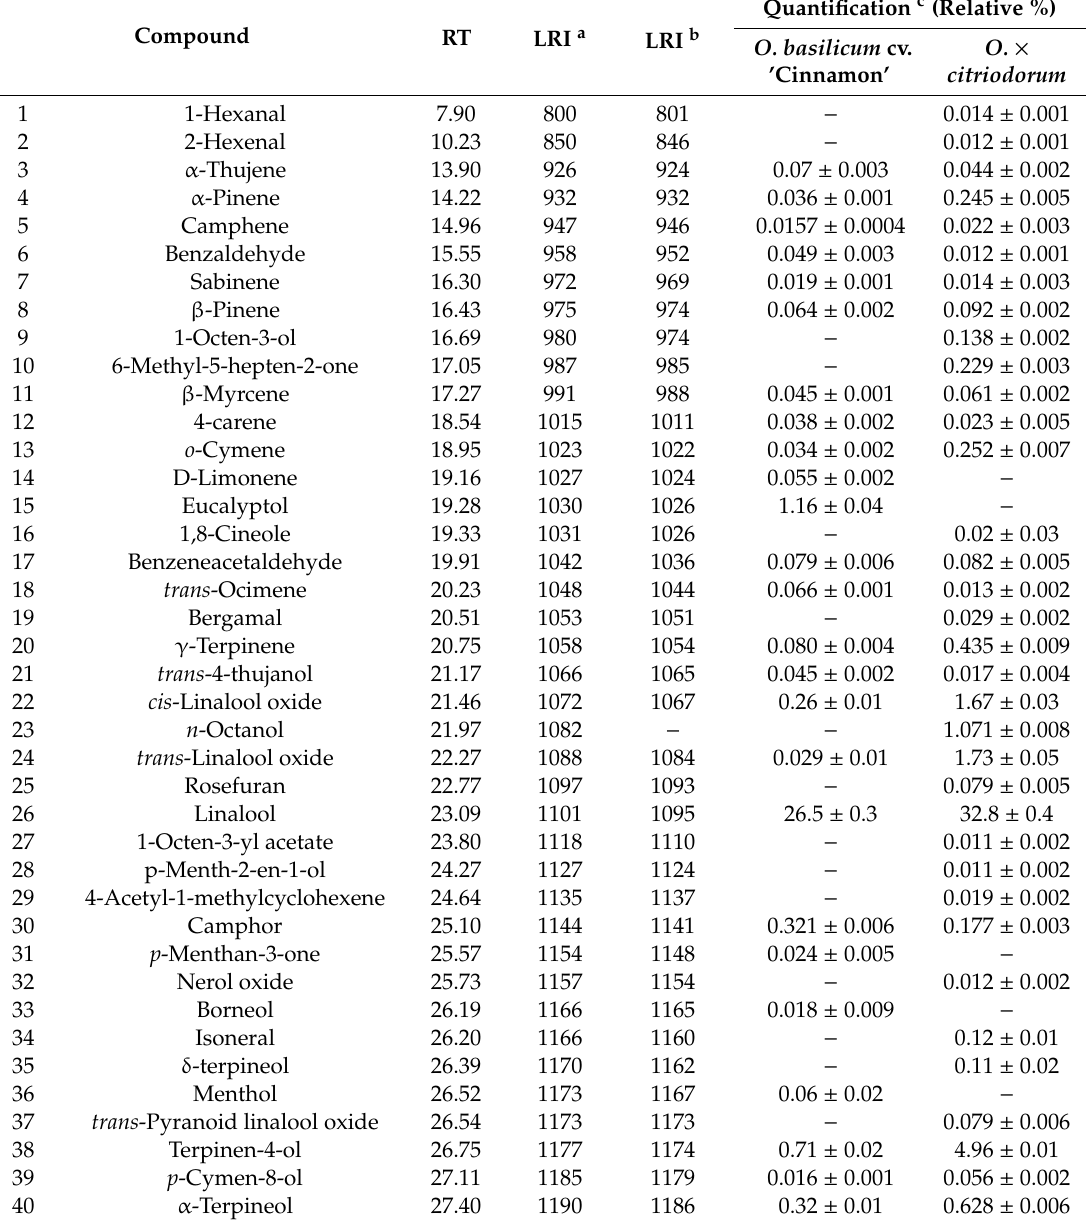
Table 2. Profile of volatile compounds identified by GC-MS in the essential oil of basil